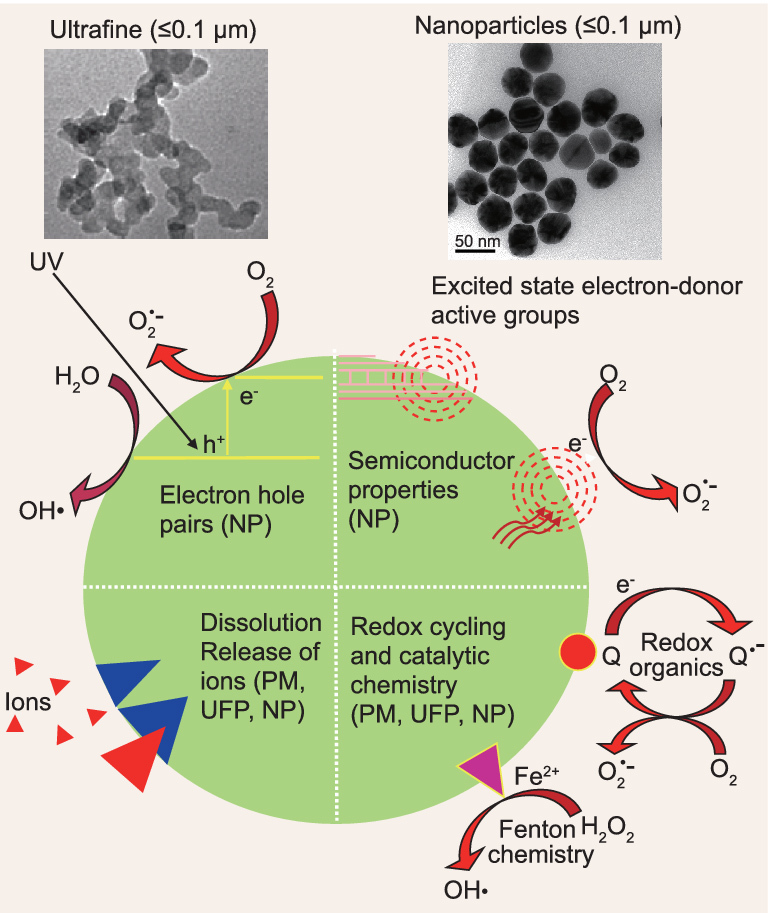
TEM images of ambient ultrafine particles and engineered nanoparticle as well as particle characteristics that promote or contribute to ROS generation. (a) Photoactivation effects of NPs, such as the formation of electron–hole pairs during ultraviolet exposure of TiO2; this effect has been associated with the generation of oxidative stress and inflammation by TiO2; (b) discontinuous crystal planes and material defects of NPs that lead to oxygen radical generation due to the active electronic state of the material surface; (c) redox cycling contributes to ROS production. This can occur due to the presence of transition metals or redox-cycling organic chemicals on the PM, UFP and NP surfaces. PMs and UFPs, for example, contain organic compounds such as quinones, which can generate ROS through redox cycling. Moreover, transition metals can generate hydroxyl radicals through the Fenton reaction. The Fenton reaction is one of the mechanisms by which metal impurities on the CNT surface can induce ROS production. Finally, (d) particle dissolution (e.g. ZnO, CdSe, Cu) can produce free ions that are capable of inducing ROS generation and oxidative stress in cells. Metal fume fever is a real-world example of this toxicity, commonly for welders.